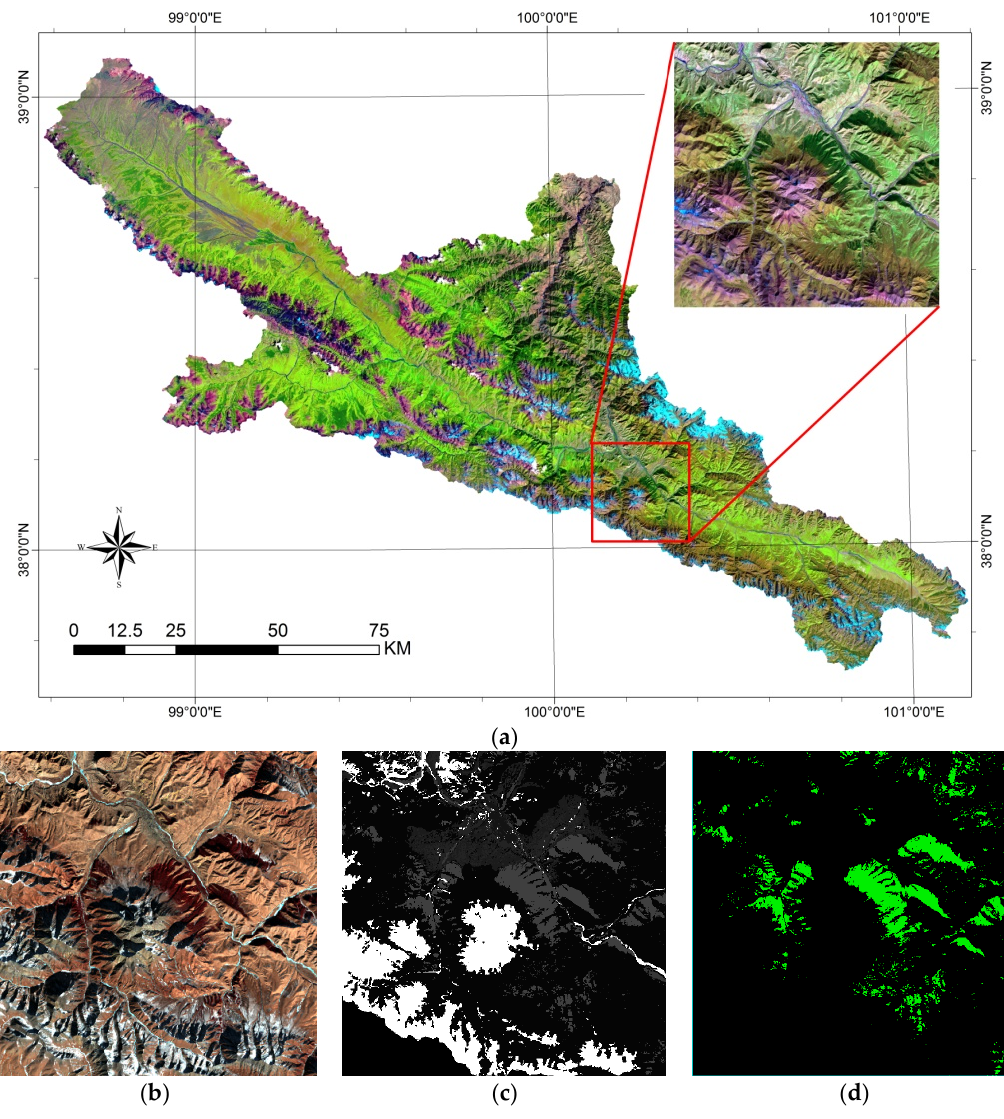
Figure 5. ( a ) map of study area; ( b ) Landsat OLI false color composite image of a second study site; ( c ) classification map; ( d ) shows the forests in green.